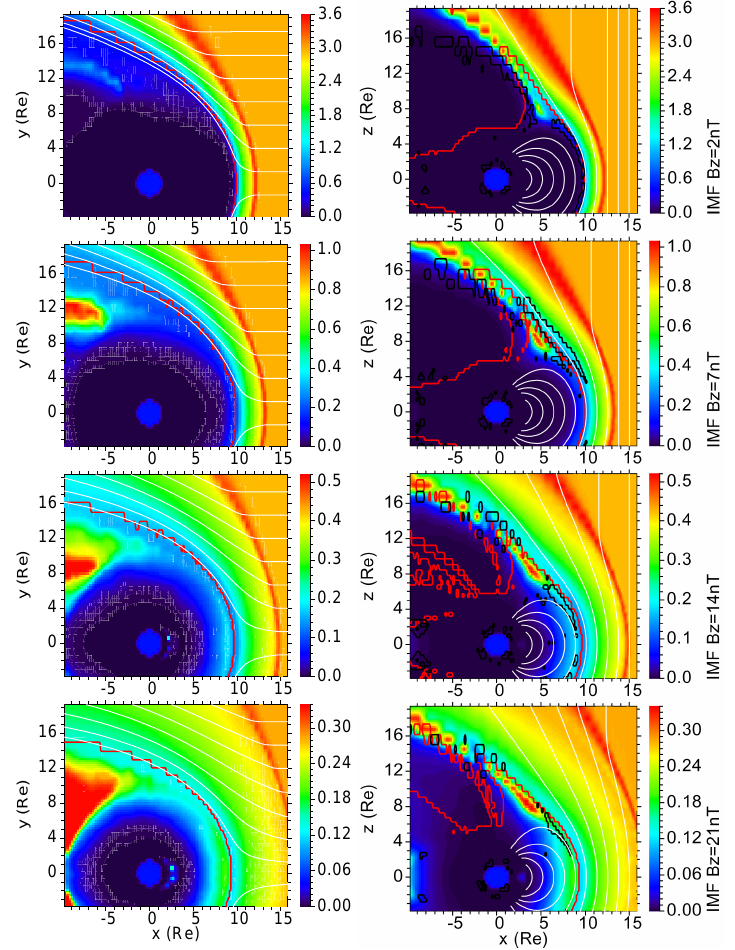
Fig. 5. The dependence of the PDL and the slow mode front on the IMF B z : 2, 7, 14, and 21nT. The other solar wind input parameters are: B x = B y =0nT, V =( − 450, 0, 0)km/s, N=6cm − 3 , and T p =T e =10eV. The other formats of this figure are the same as those in Fig. 3.